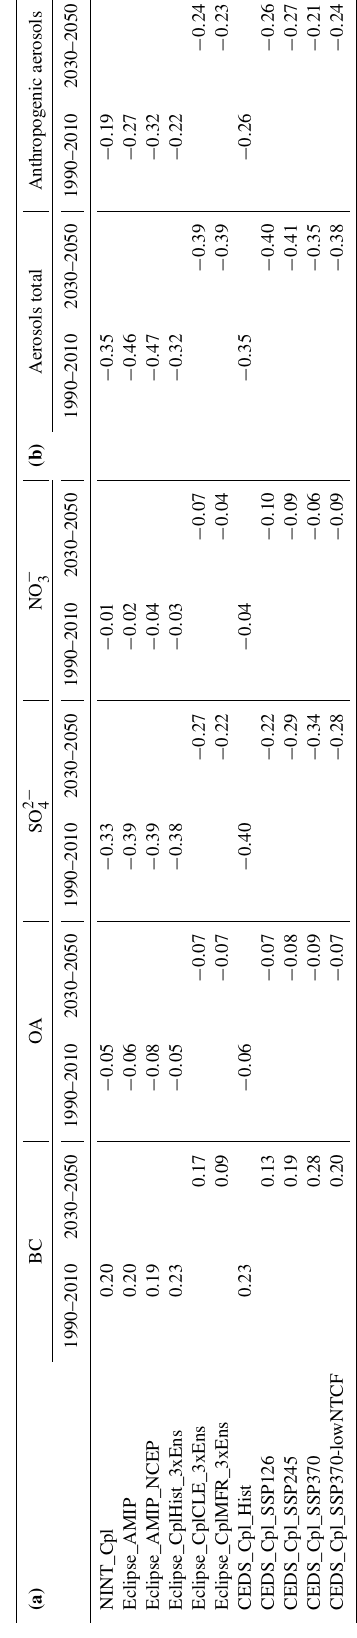
CMIP6 near-past simulations show a contribution of − 0 . 19 to − 0 . 26 Wm − 2 from anthropogenic aerosols (Table 6b). The AMIP-type Eclipse simulations calculated a much larger RF ARI of − 0 . 47 Wm − 2 for the same period, which can be mainly due to the increase in the positive forcing of the BC aerosols in the coupled simulations due to larger burdens. This effect is amplified due to the larger sea-ice